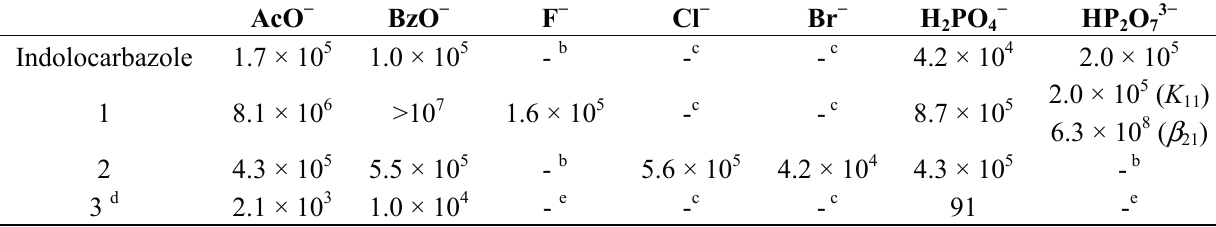
Table 1. Fluorescence association constants for 1 in acetonitrile.